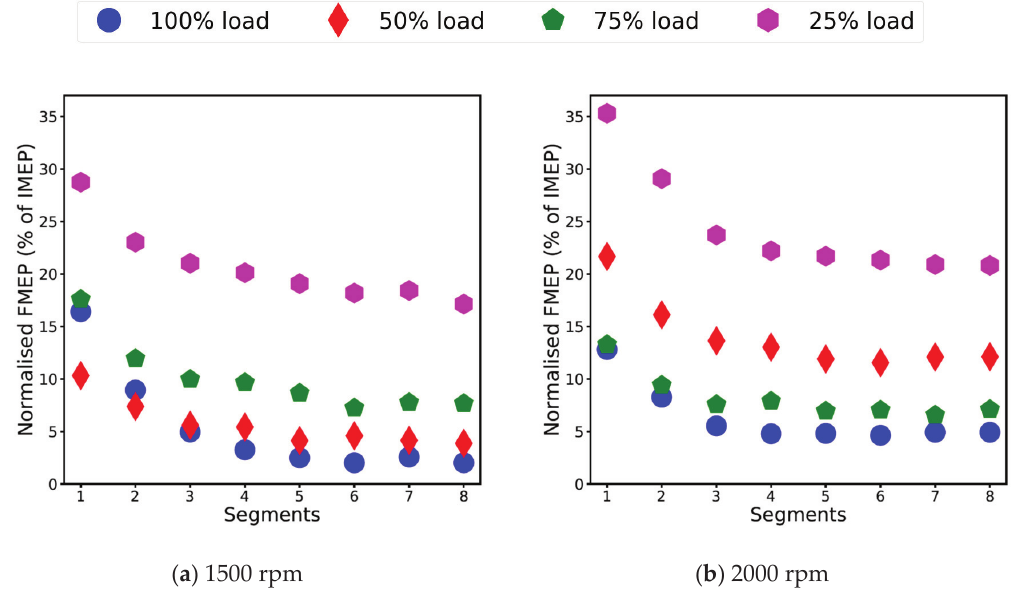
Figure 9. Normalised FMEP (by IMEP) at each load in each segment at ( a ) 1500 and ( b ) 2000 rpm. The blue circle represents 100% load, the red diamond 50% load, the green pentagon 75% load and the pink hexagon 25% load.